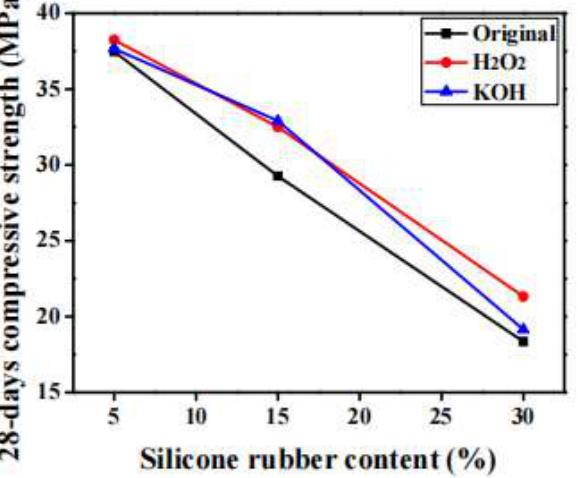
Figure 9. Compressive strength of silicone rubber mortar at 28 days [19]. Table 5. Chemical elements in rubber crumb before and after surface treatment in EDX analysis [5]. Before Treatment of Element